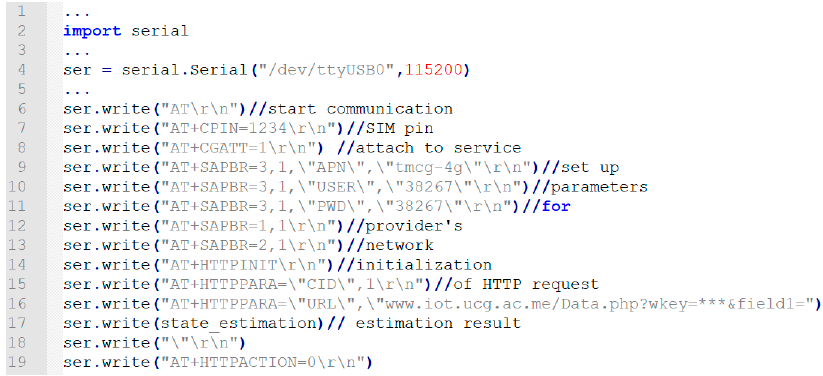
Figure 10. Part of the program code for GPRS communication.